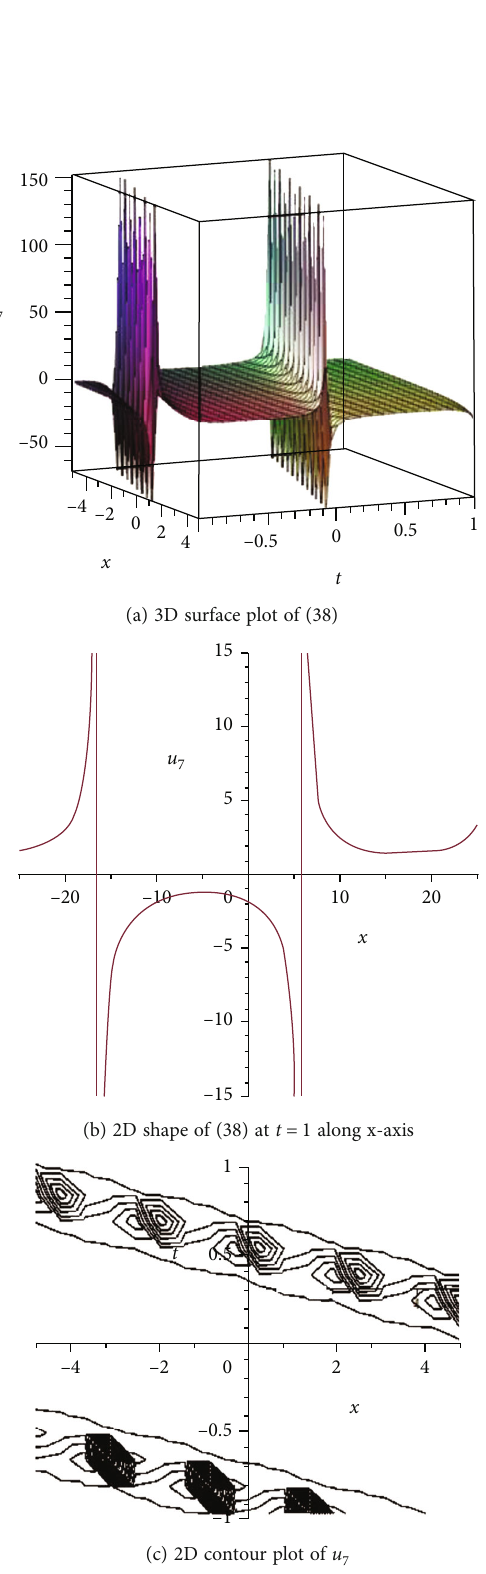
a = 0 : 1 , a = 0 : 2 , b = 0 : 24 , b 1 2 1 = 0 : 006 , σ = 0 : 0256 , σ = 0 : 0512 , y = 3 , θ = 0 , and ξ 1 2 2